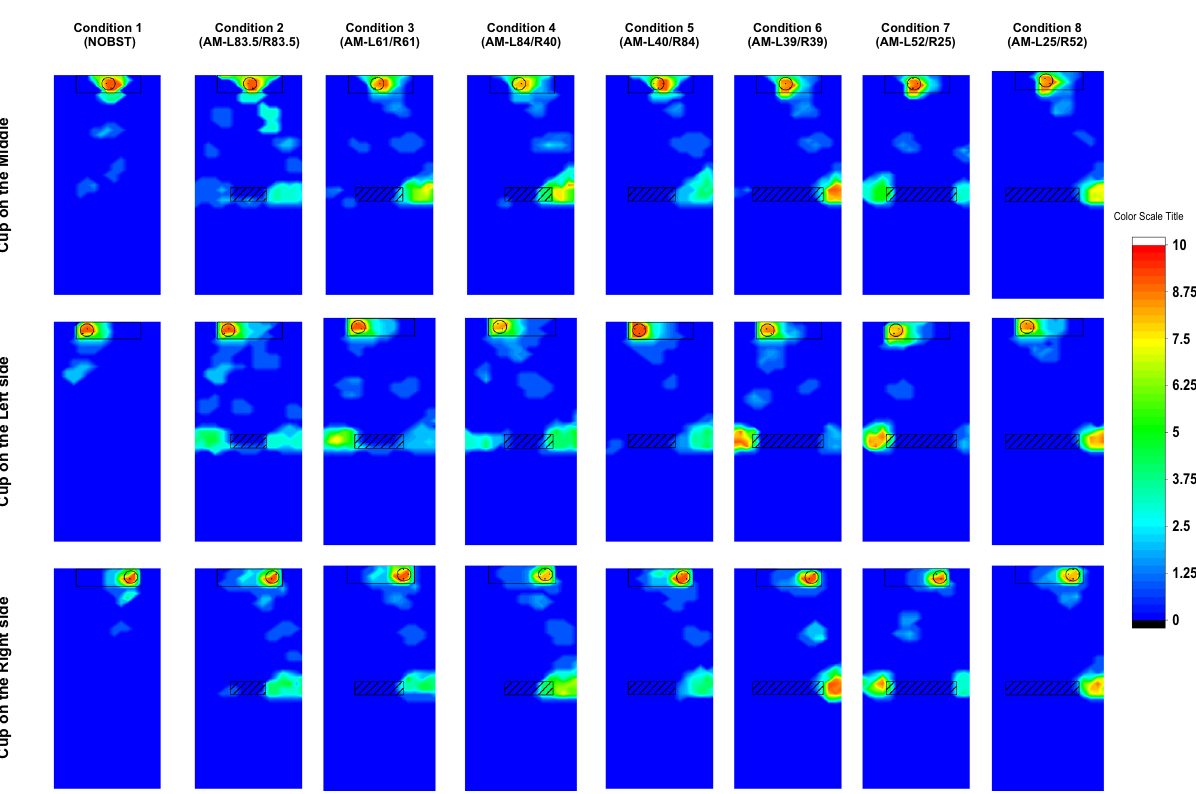
Figure 6. The gaze allocation on the target location, path area, and avoidance margins (hatched lines indicate obstacle and solid circle indicates cup